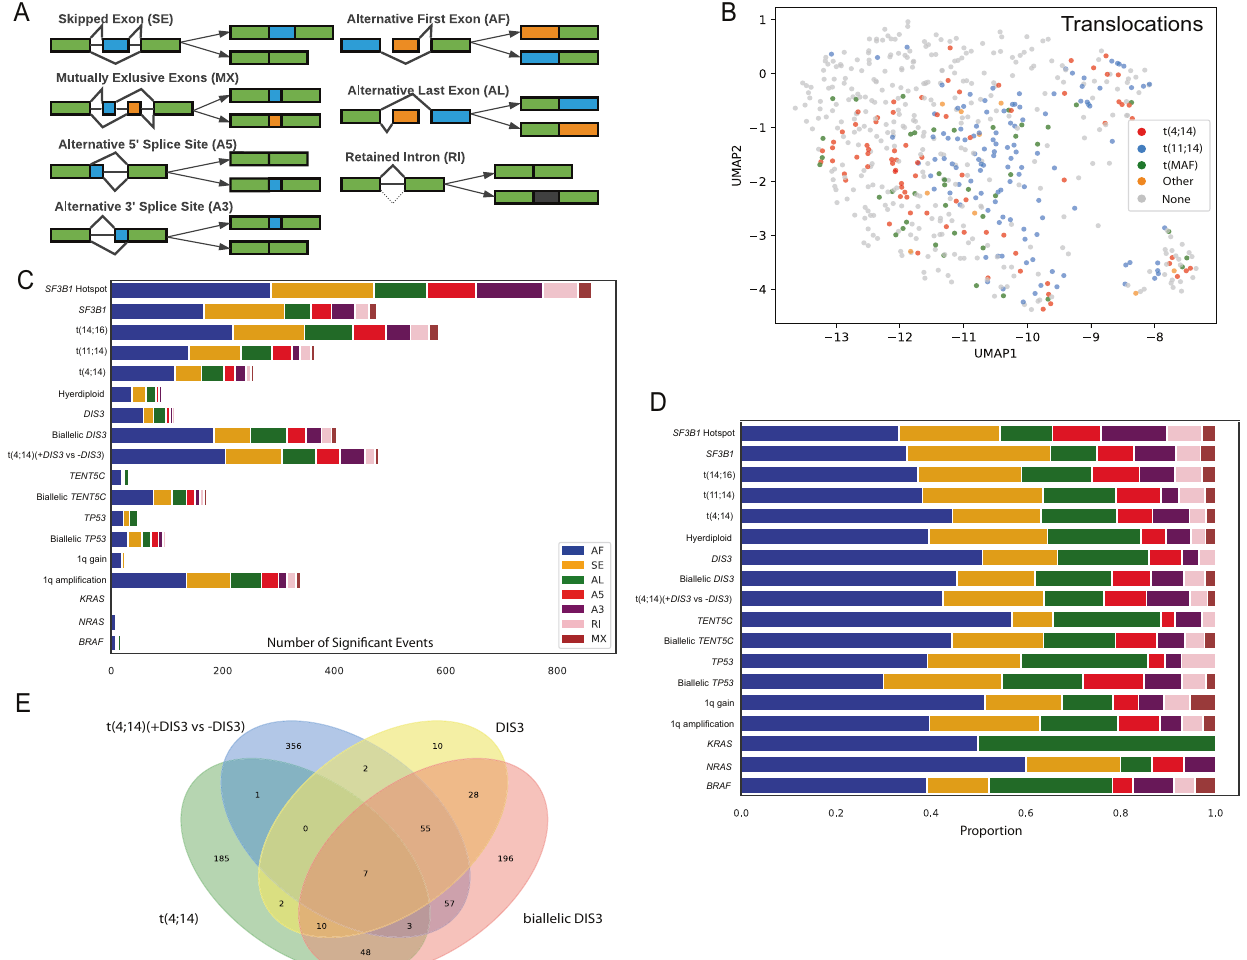
Fig. 1 Alternative splicing types among different cytogenetic and mutation comparisons. A Seven fundamental AS types. B Unsupervised clustering of 598 NDMM samples by transcriptome splicing pro fi les with highlighted translocations. C Number of alternatively spliced events among genomic abnormality comparisons. D Composition of alternatively spliced events within each comparison. E Venn diagram of consistent AS events among t(4;14), t(4;14) + DIS3 , biallelic DIS3 and DIS3 mutation